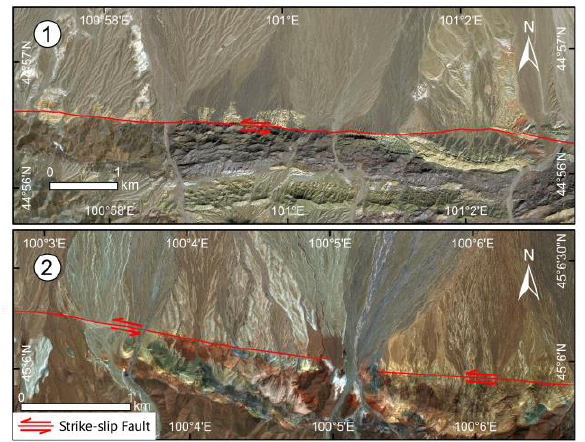
Figure 4. The two typical sites for the strike-slip fault. Landsat 7 ETM+ images with scene size (185  185 km), pixel resolution 30 m were used in the combination of 741 (RGB) as the most suitable for defining the fault (Sevki et al., 2009). The ENVI 4.5 (Environment for Visualizing Images) software was